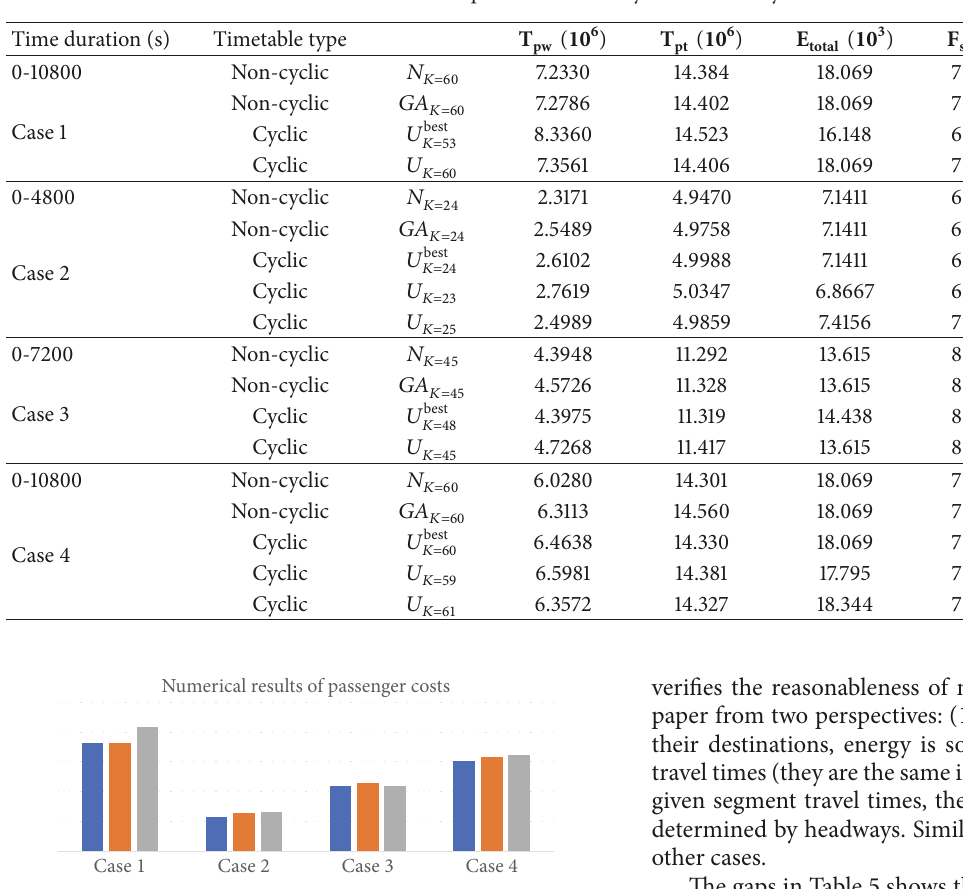
Table 5: Comparison between cyclic and non-cyclic timetables.